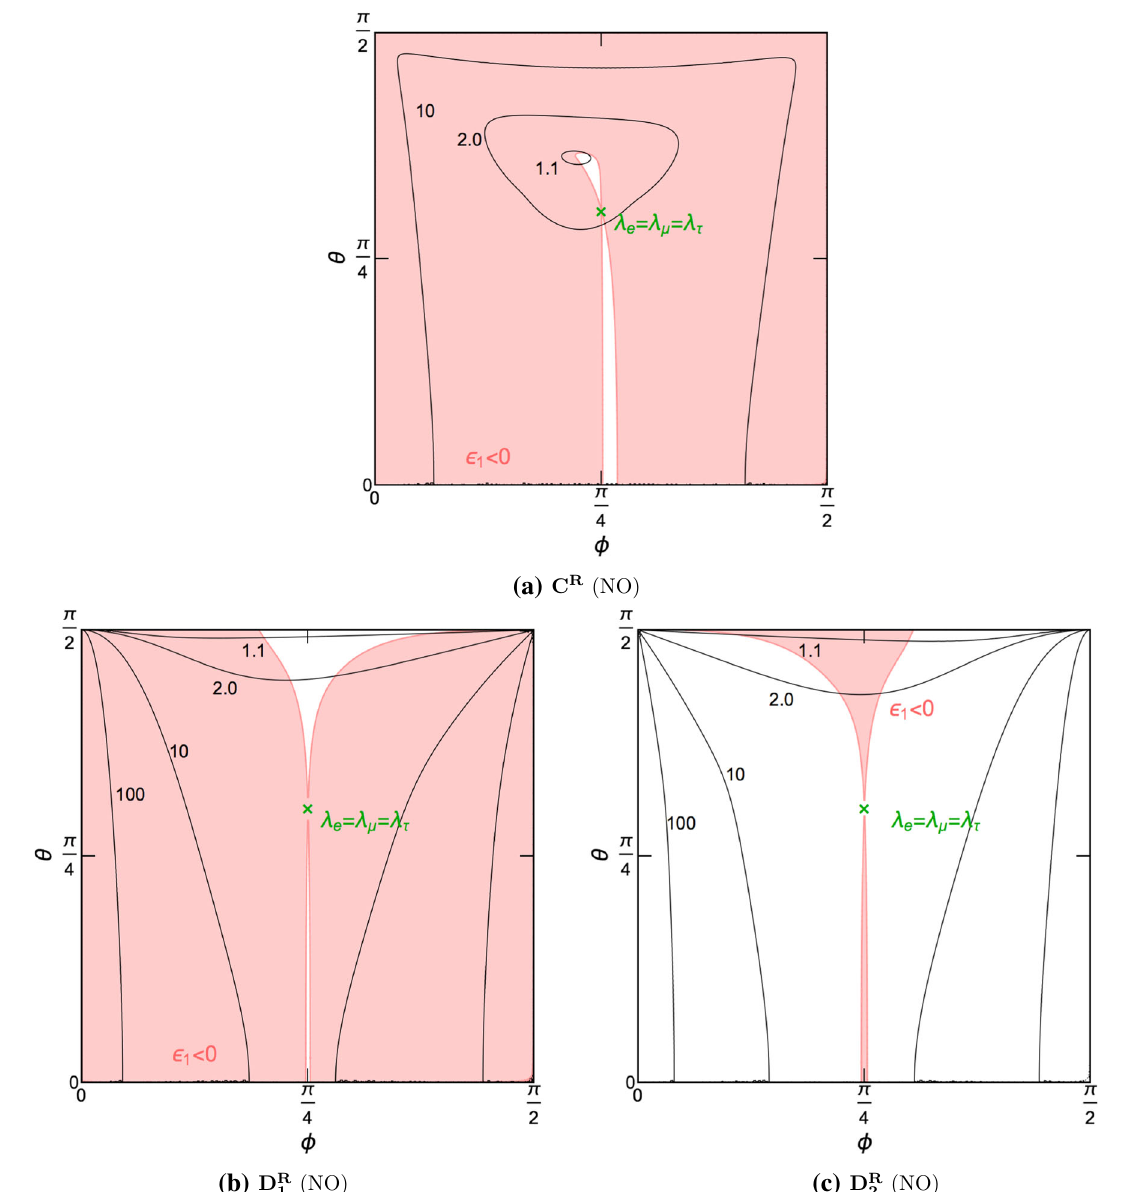
Fig. 6 The predictions for the sign of the baryon asymmetry in the singlet models. The red shaded areas show the parameter region of the (θ,φ) plane where the asymmetry parameter (cid:14)